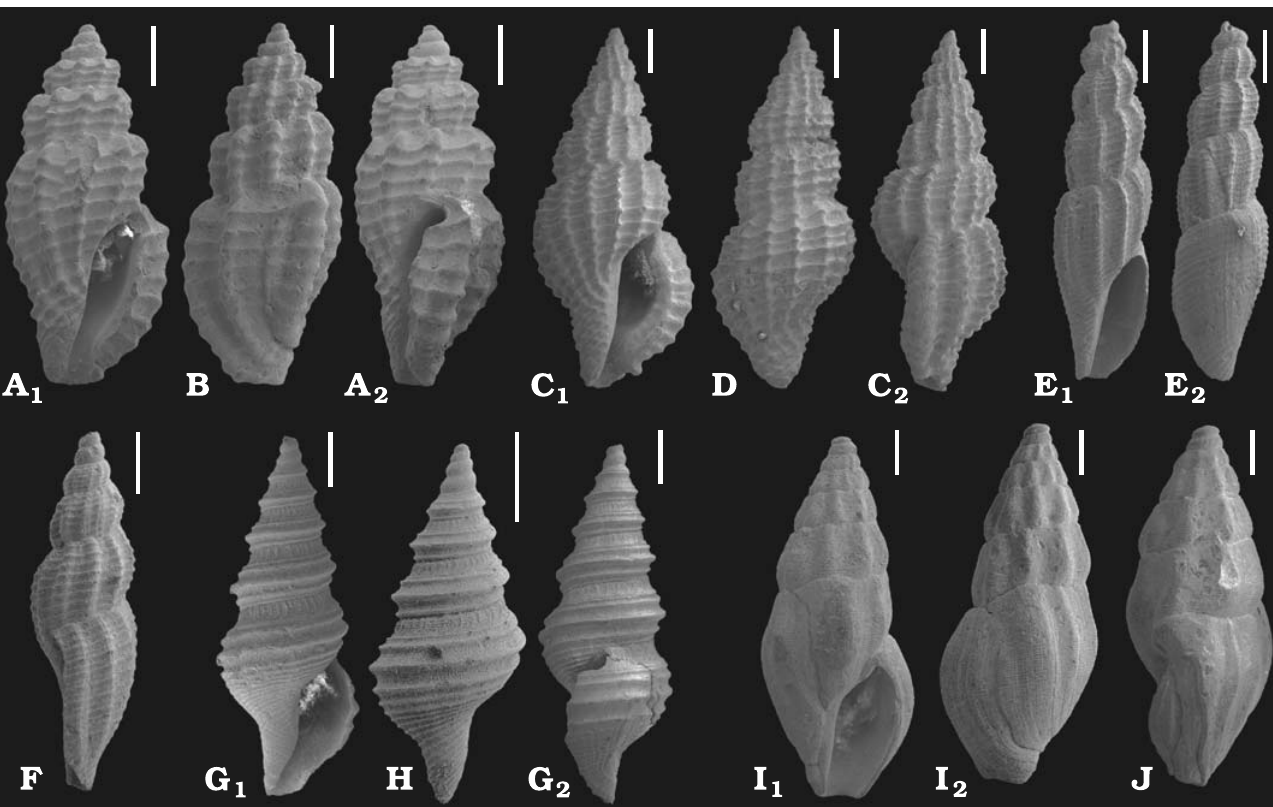
Fig. 8. SEM images of shell features of conoidean gastropods from early Serravallian of western Ukraine, Horodok (A, B) and Varovtsi (C–J). A , B . Pyr- gocythara turrispiralata sp. nov. A . MGGC-24515/11. B . MGGC-24515/9. C , D . Raphitoma cf. R. ringicula (Boettger, 1902). C . MGGC-24522/1. D . MGGC-24522/3. E , F . Andonia sp. aff. A. transsilvanica (Hoernes and Auinger, 1890). E . MGGC-24523/1. F . MGGC-24523/3. G , H . Teretia cf. T. turritelloides (Bellardi, 1847). G . MGGC-24524/3. H . MGGC-24524/5. I , J . Haedropleura sp. aff. H. septangularis (Montagu, 1803). I . MGGC-24520/6. J . MGGC-24520/11. Views: A 1 , C 1 , E 1 , G 1 , I 1 , apertural; B, D, E 2 , H, I 2 , dorsal; A 2 , C 2 , F, G 2 , J, lateral. Scale bars 1